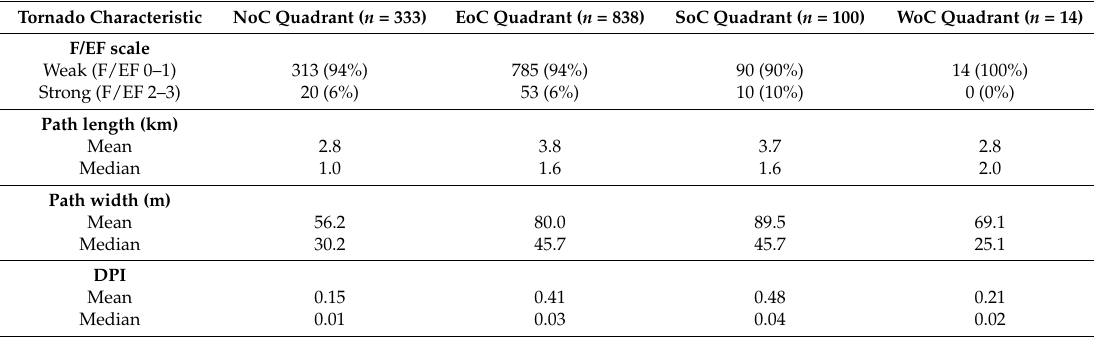
Table 7. Descriptive statistics for the north-of-center (NoC), east-of-center (EoC), south-of-center (SoC), and west-of-center (WoC) quadrants.